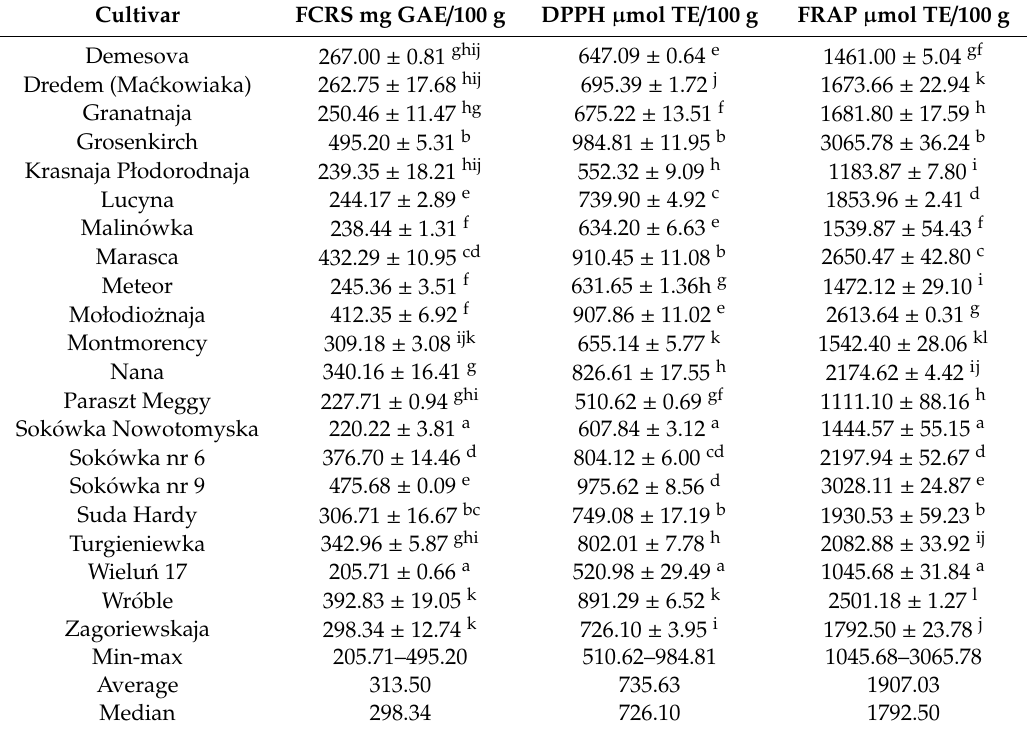
Values are expressed as mean ± standard deviation; the same superscripted letters within the same column means a statistically homogeneous group ( p =